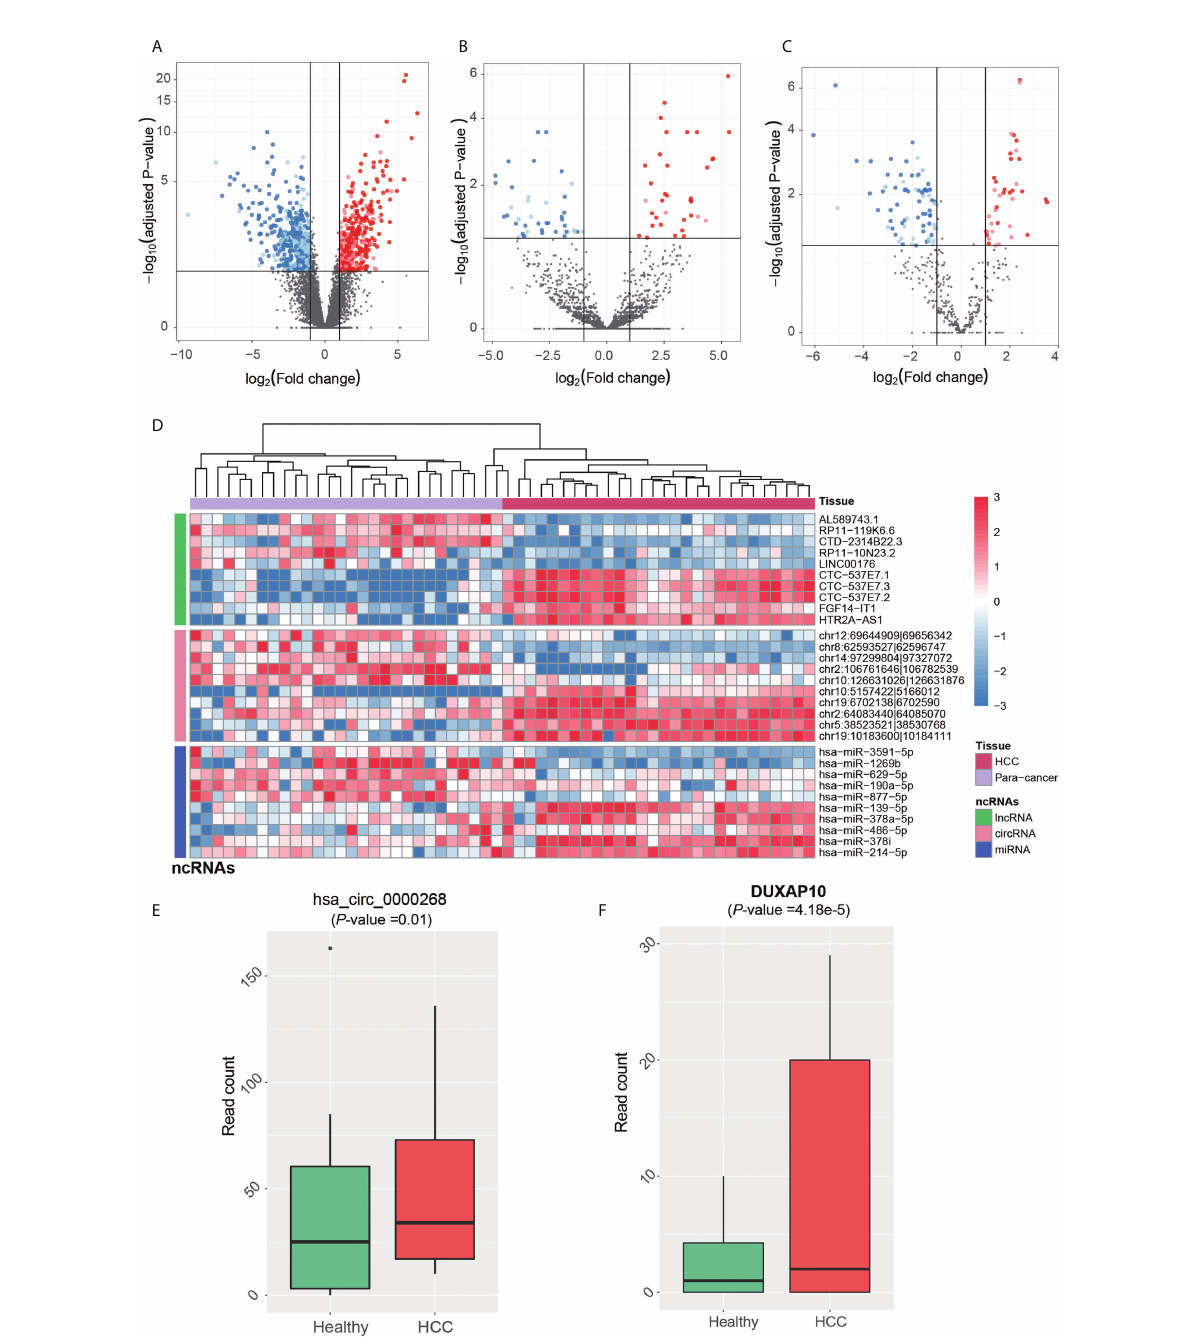
FIGURE 3 Tumorigenesis-associated dysregulated ncRNAs in HCC. The expression patterns of lncRNAs, circRNAs, and miRNAs are displayed in (A-C) . The red and blue points represent up- and downregulated ncRNAs in HCC. The solid points were also detected to be differentially expressed in the independent dataset. (D) The normalized expression levels of each of the top 10 ncRNAs by differential expression analysis, which are separated by three panels. HCC and para-cancerous samples were clustered by hierarchical clustering analysis, and are represented by the red and purple band on the top. The expression patterns of circRNA (hsa_circ_0000268) and lncRNA DUXAP10 in blood exosomes of HCC and healthy donors are displayed in (E, F)